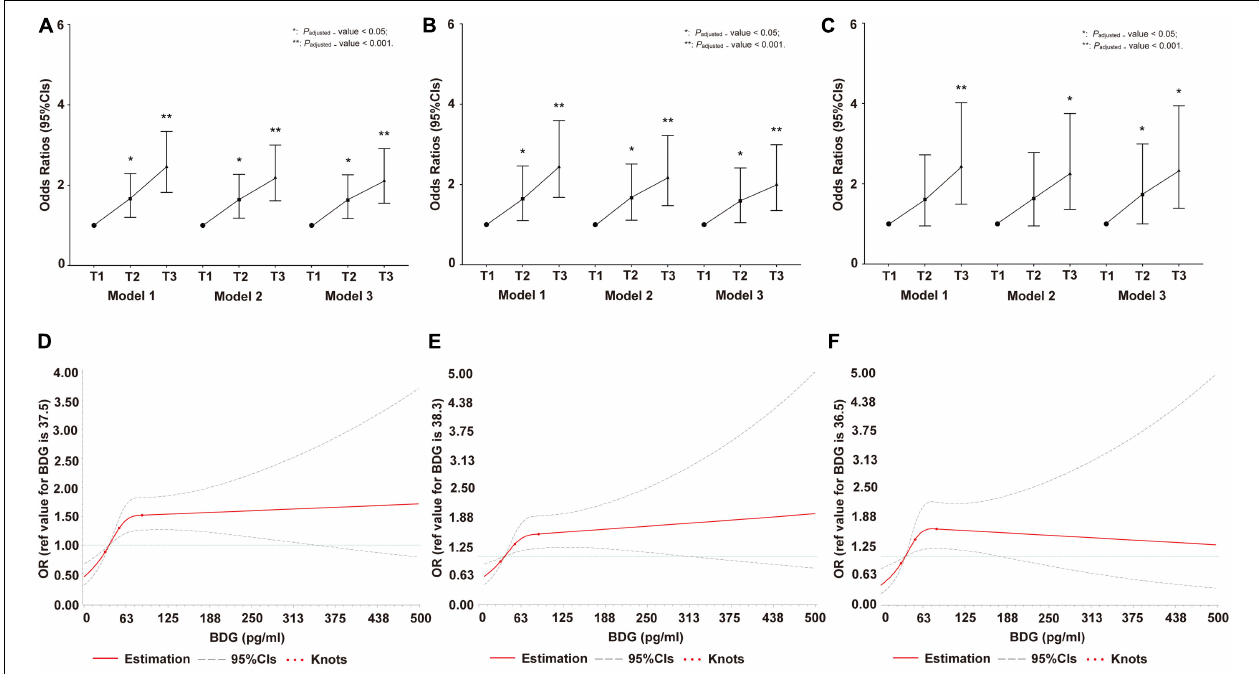
FIGURE 2 | Invasive fungal infection (IFI) on hypostatic pneumonia (HP) risk in cross-sectional study. (A) The odds ratio ( OR ) and 95% CIs of IFI on HP risk in total population. (B) The OR and 95% CIs of IFI on HP risk in men. (C) The OR and 95% CIs of IFI on HP risk in women. (D) Restricted cubic spline of association between β -D-Glucan (BDG) concentration and OR (95% CIs ) of IFI on HP risk in total population. (E) Restricted cubic spline of association between BDG concentration and OR (95% CIs ) of IFI on HP risk in men. (F) Restricted cubic spline of association between BDG concentration and OR (95% CIs ) of IFI on HP